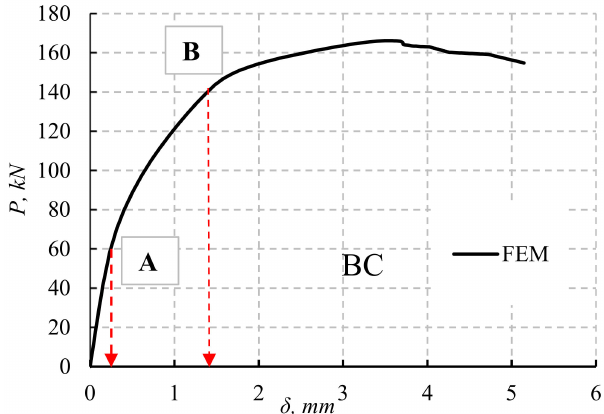
Figure 17. BC–load deflection curve